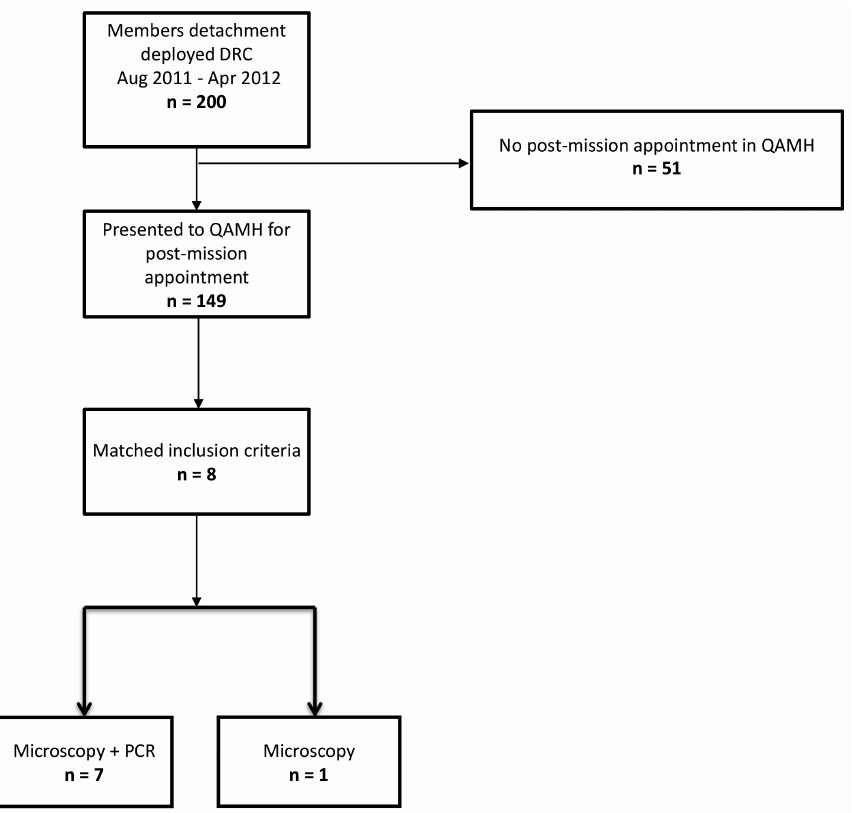
Figure 1. Inclusion flowchart. DRC: Democratic Republic of Congo, QAMH: Queen Astrid Military Hospital.